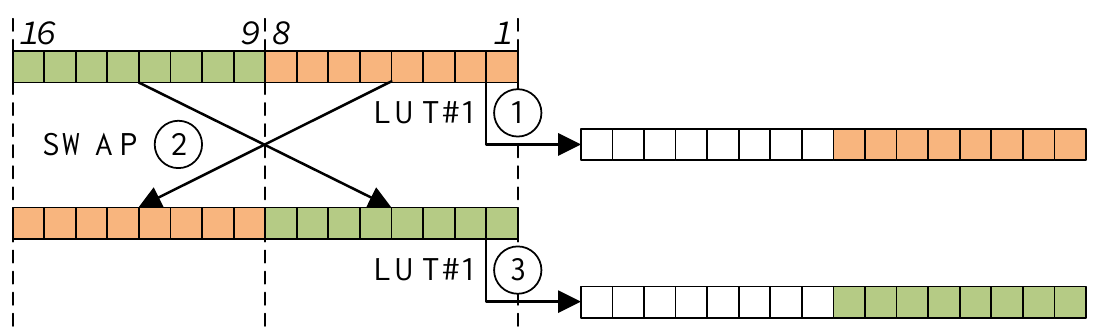
Figure 1. Look-up table access for substitution layer on 16-bit MSP430. Each square block represents 1-bit. 1 (cid:13) : LUT access with 1–8-th bits, 2 (cid:13) : exchanging lower and higher bytes, 3 (cid:13) : LUT access with 9–16-th